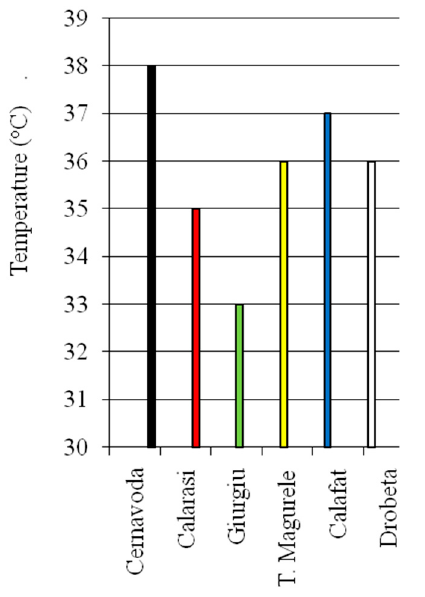
Figure 3. Air temperature in the cities that have been crossed during the period under discussion.